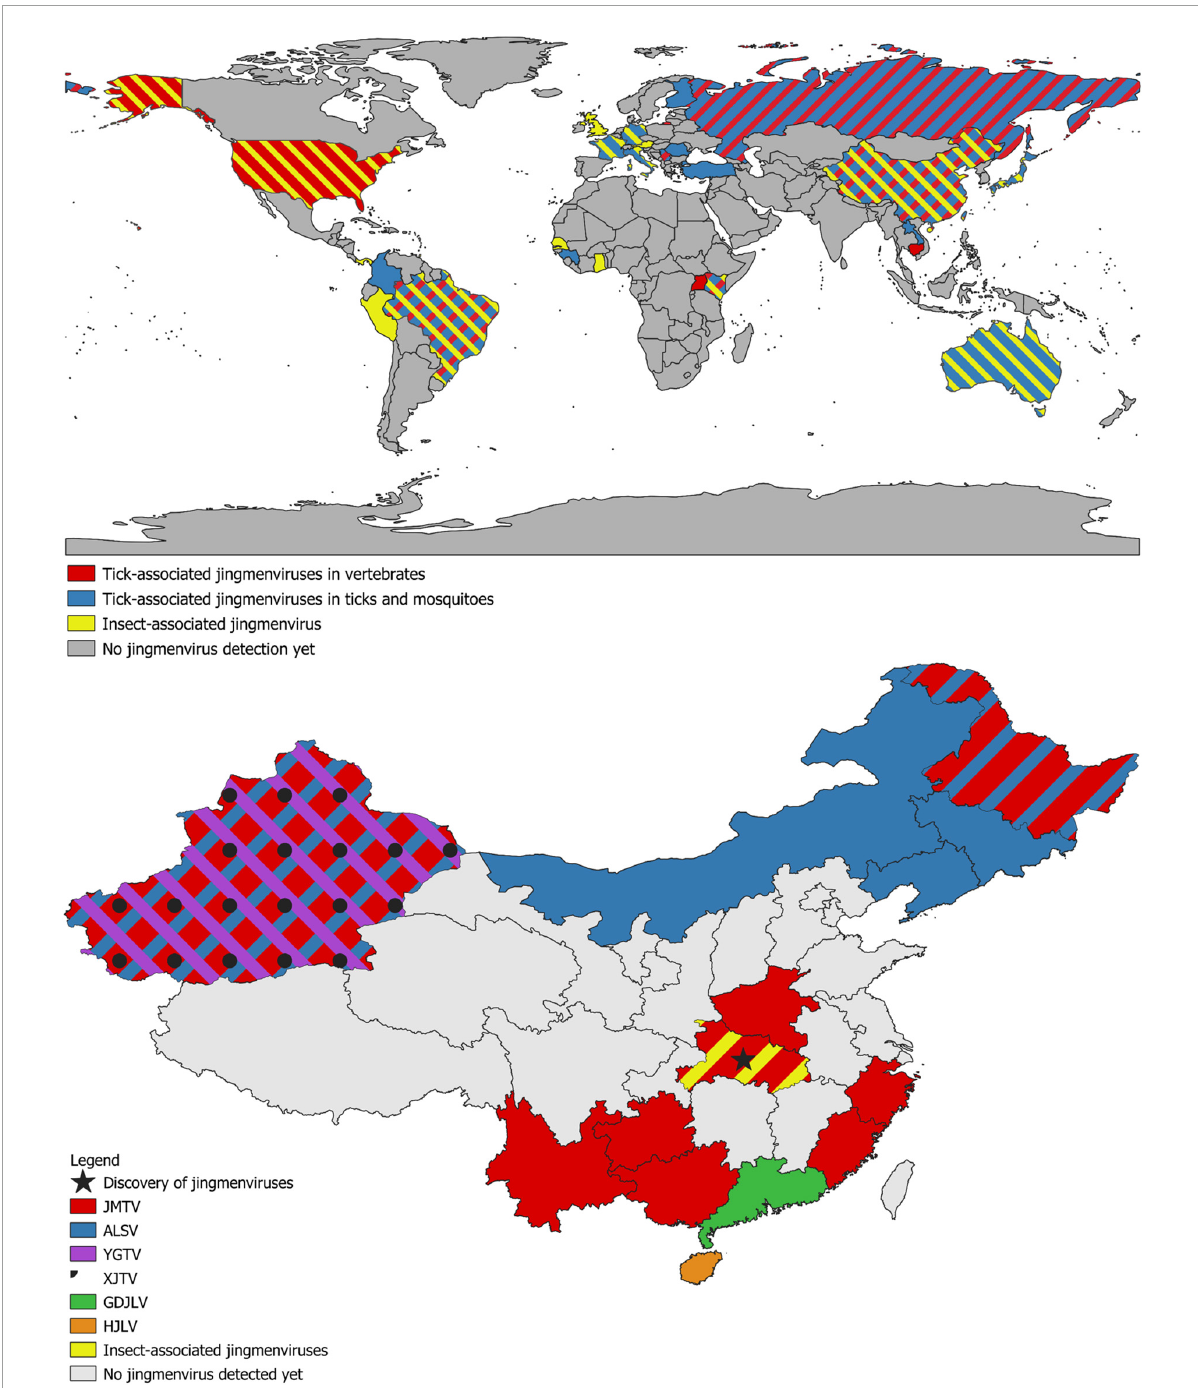
FIGURE3 (Top) World map of detections of jingmenvirus sequences. Countries in which tick-associated jingmenviruses have been detected in vertebrates contain red; countries in which tick-associated jingmenviruses have been detected in ticks and mosquitoes contain blue; countries in which insect-associated jingmenviruses have been detected contain yellow. (Bottom) Map of detections of jingmenvirus sequences in Chinese provinces. The province where jingmenviruses were first discovered is highlighted with a black star. Provinces in which Jingmen tick virus (JMTV) has been detected contain red; provinces in which Alongshan virus (ALSV) has been detected contain blue; provinces in which Yanggou tick virus (YGTV) has been detected contain purple; provinces in which Xinjiang tick virus (XJTV) has been detected contain black spots; provinces in which Guangdong jingmen-like virus (GDJLV) has been detected contain green; provinces in which Hainan jingmen-like virus (HJLV) has been detected contain orange; provinces in which insect-associated jingmenviruses have been detected contain yellow. All other provinces are in gray. These maps were drawn using the QGIS software and open-source geographic